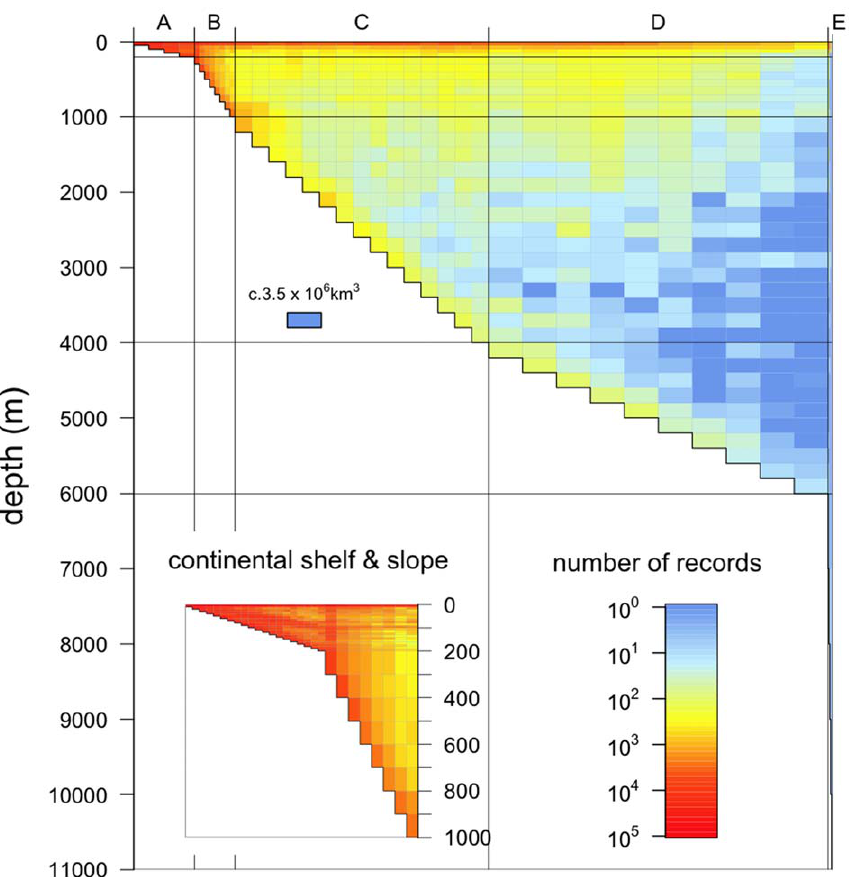
Figure 2. Global distribution within the water column of recorded marine biodiversity. The horizontal axis splits the oceans into five zones on the basis of depth (see Table 1), with the width of each zone on this axis proportional to its global surface area. The vertical axis is ocean depth, on a linear scale. This means that area on the graph is proportional to volume of ocean. For instance, in the deep sea each cell of 200m depth represents c. 3.5 6 10 6 km 3 (see cell drawn separately for scale). The number of records in each cell (each unique combination of sample and bottom depth, following the scheme in Table 1) is standardised to the volume of water represented by that cell, and then log 10 -transformed. The inset shows in greater detail the continental shelf and slope, where the majority of records are found.